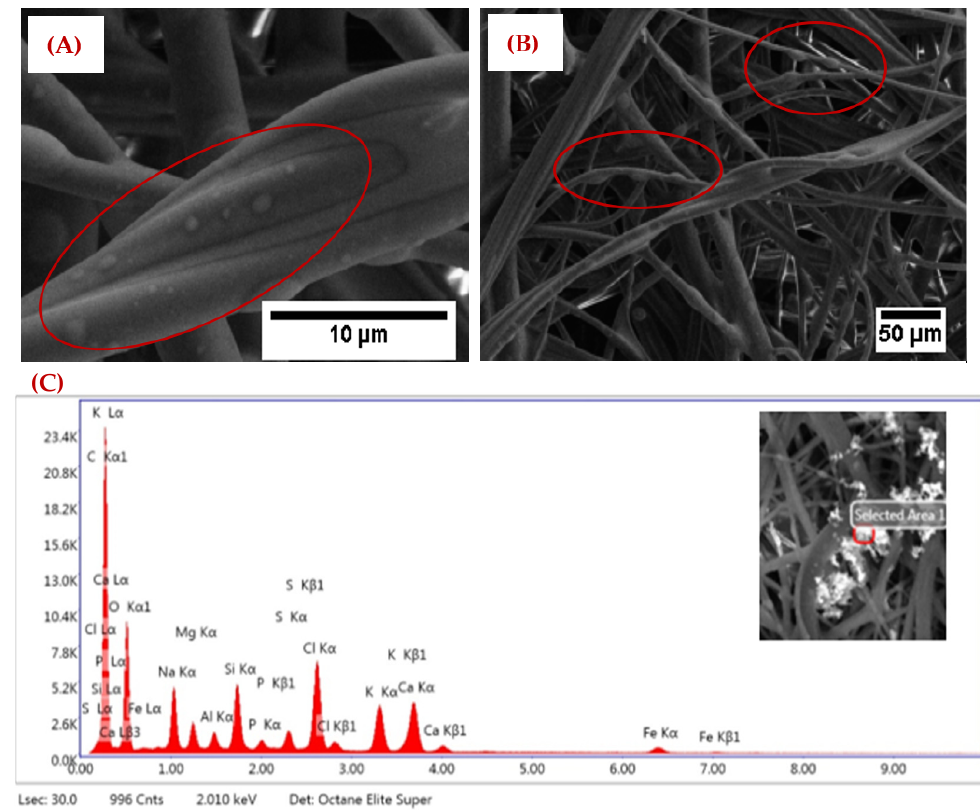
Figure 2. The melt blown filtering layer ( A ) An SEM image of captured PM at 10 μ m, ( B ) at 50 μ m, and ( C ) the EDX spectrum of captured PM.